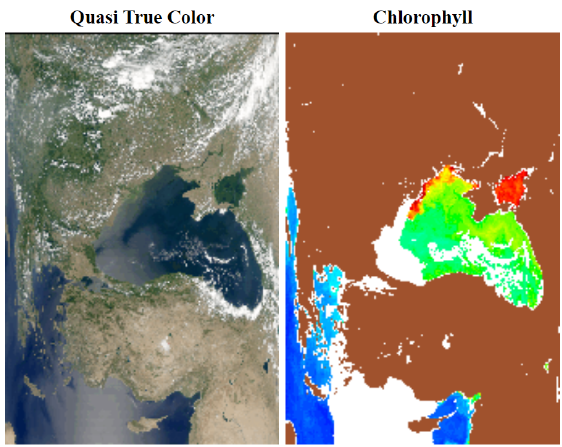
Figure 5. Satellite images from the MODIS Aqua platform during the day of the predicted dust transport over the Black Sea region for 30.07.2020.